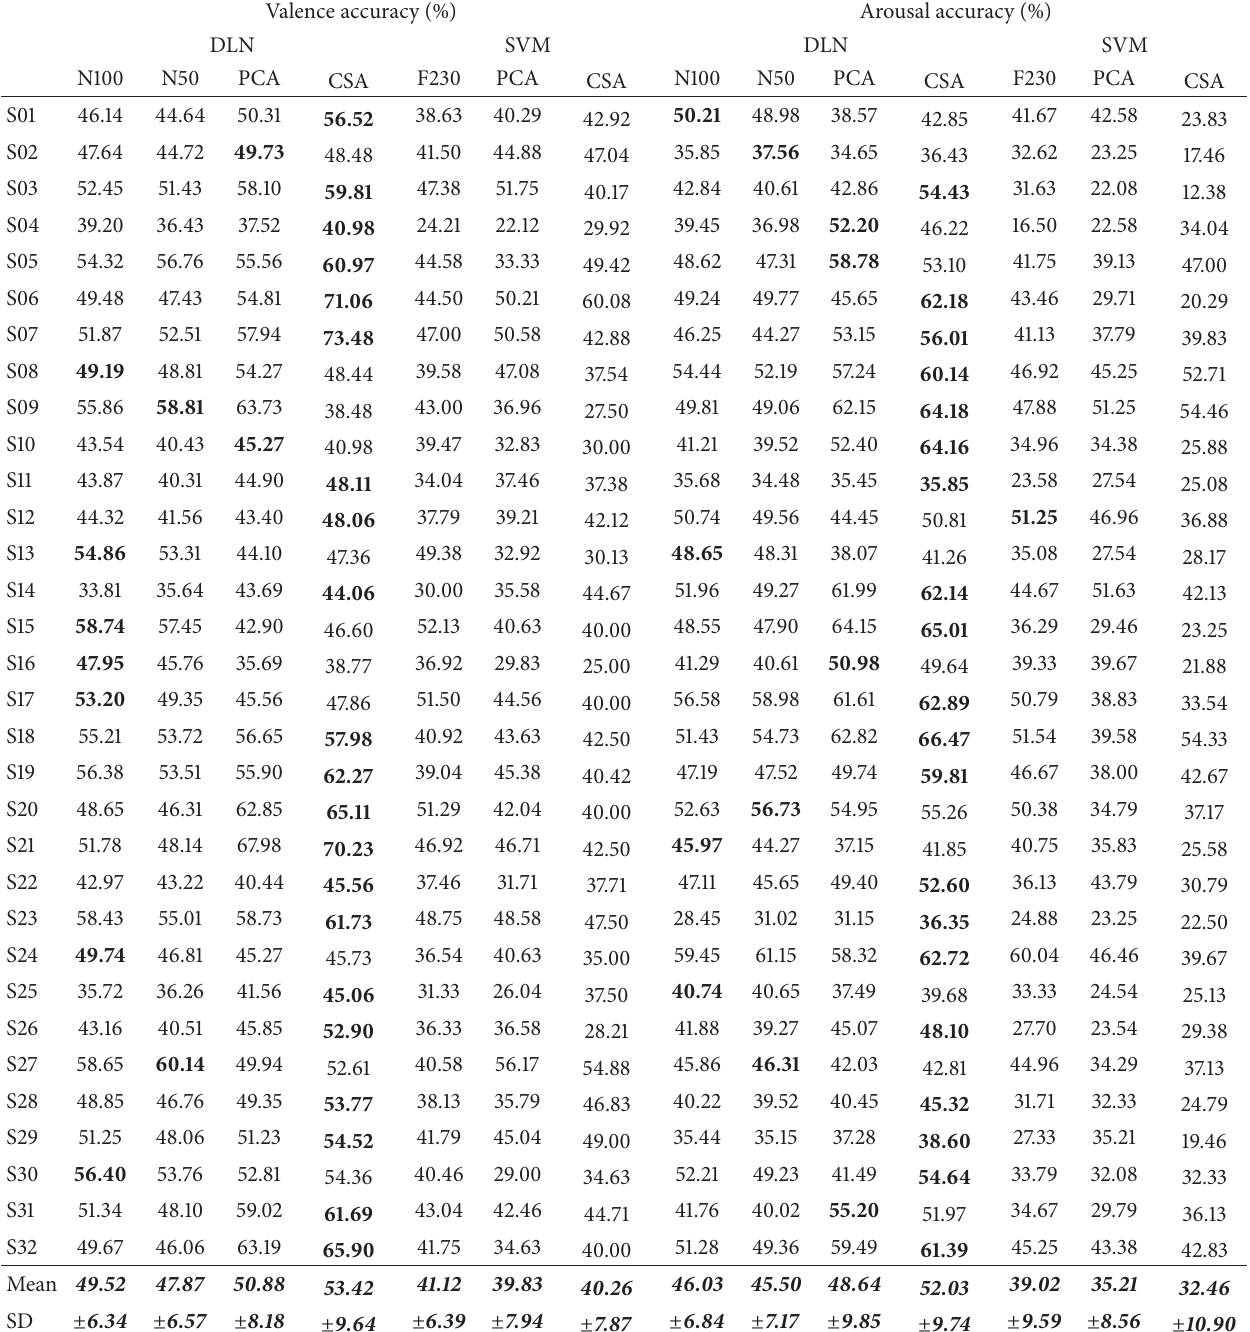
Table 2: Valence and arousal state classification accuracy with leave-one-subject-out cross